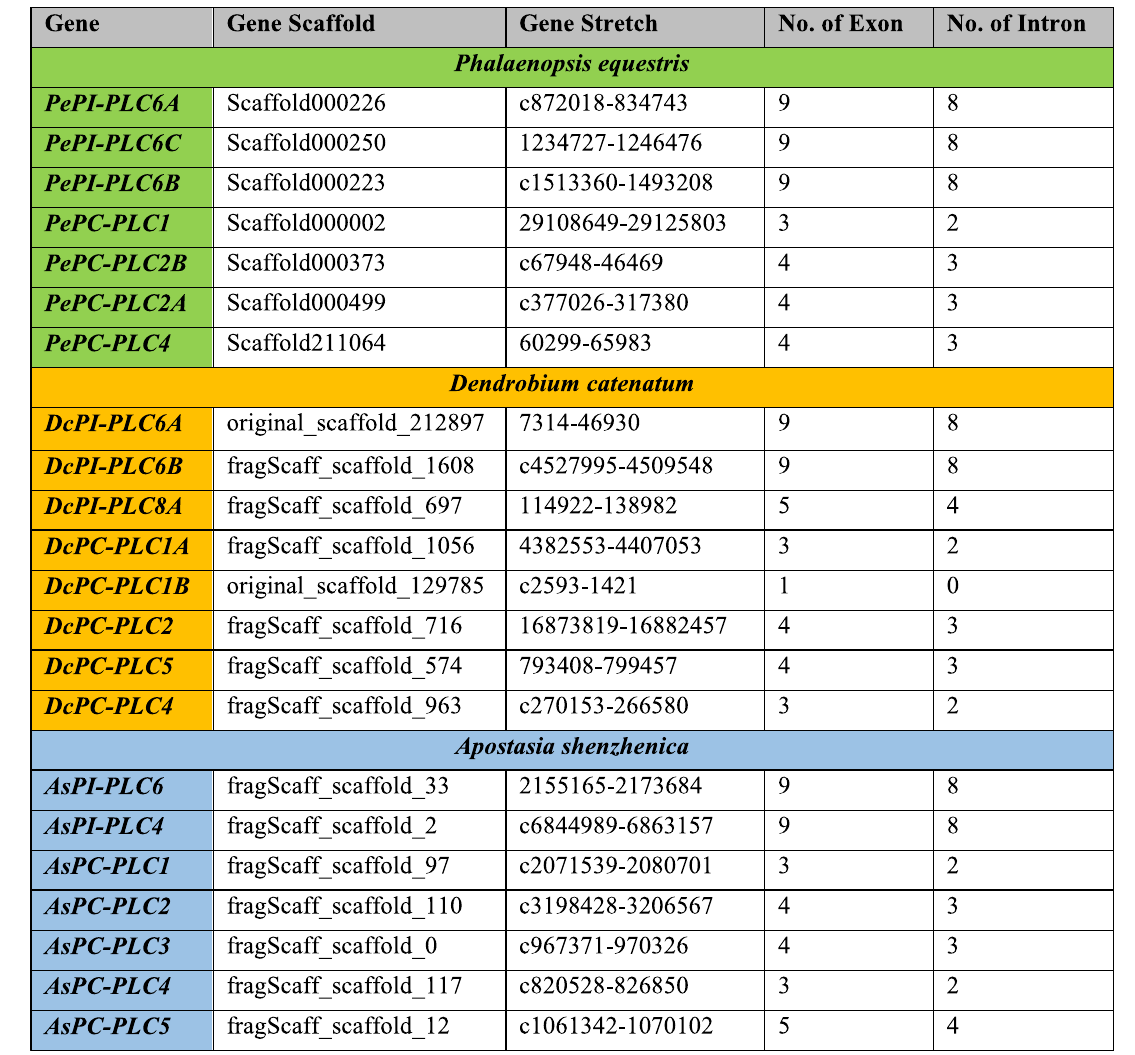
Table 3 Gene characterization table of PePLC , DcPLC , and AsPLC